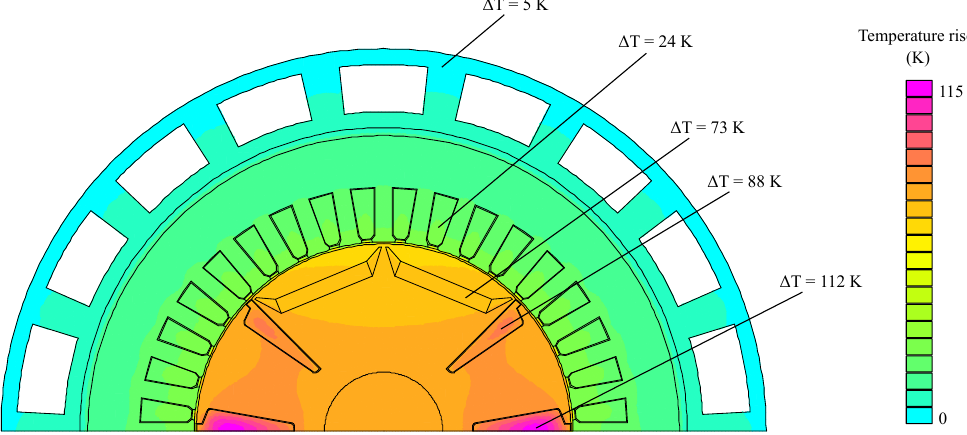
Figure 27. Temperature increase map with a water cooling